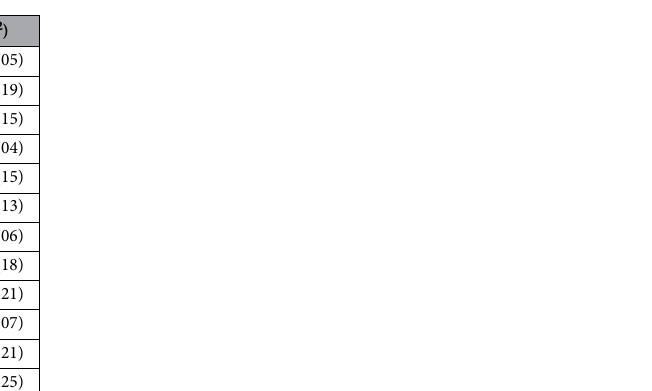
Cr x x Sn compositions measured at 30 K. −